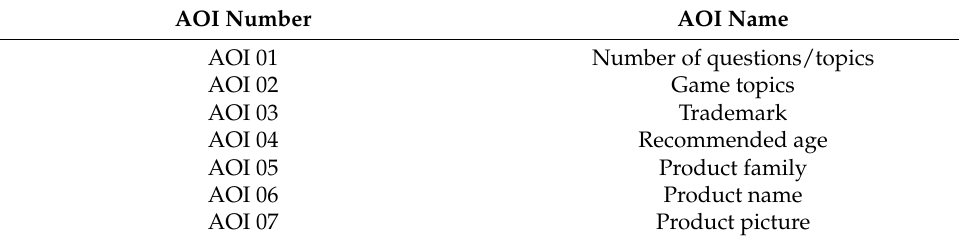
Figure 1. Toy packaging ( a ) and Areas of Interest ( b ). Source: Prepared by the authors. Table 1. Toy packaging. Areas of Interest and description.